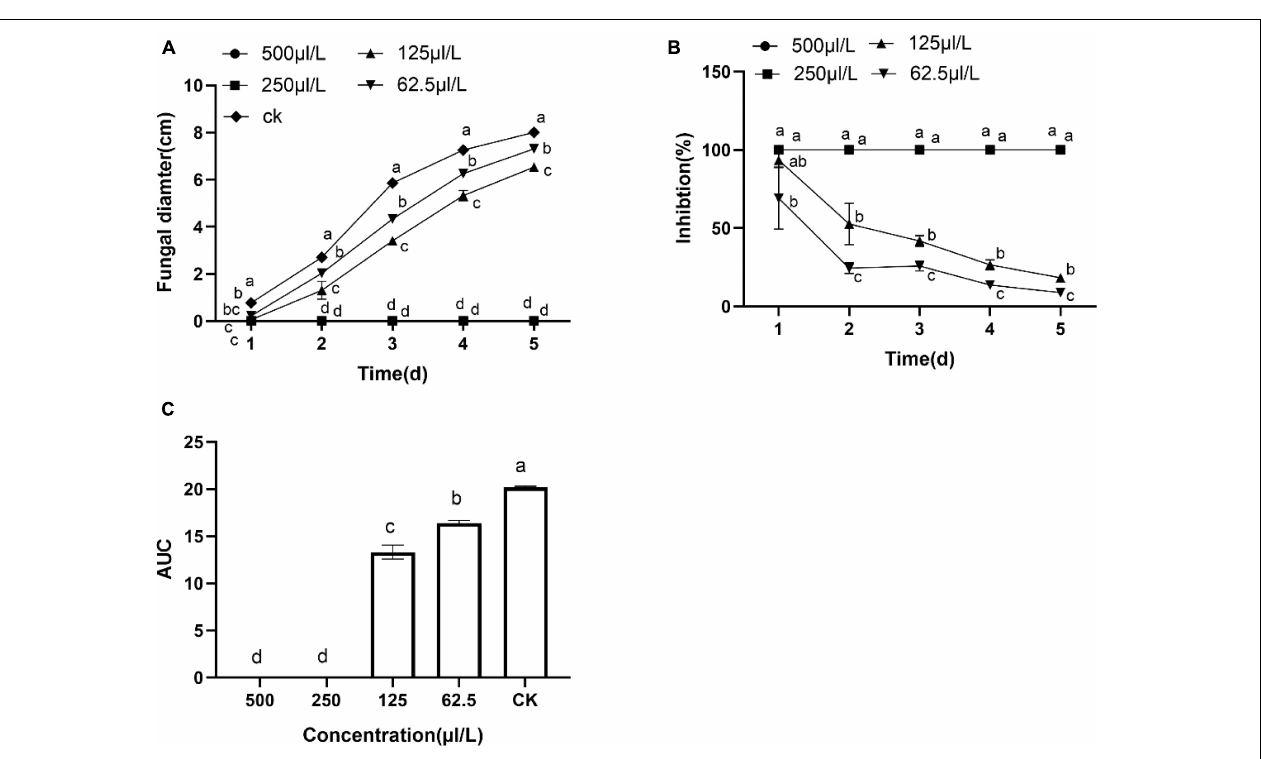
FIGURE 2 | The dimethyl trisulfide inhibition on the mycelia growth of Botryosphaeria dothidea . (A) The colony diameters of Botryosphaeria dothidea treated by the various concentration of dimethyl trisulfide. (B) The inhibition of various concentrations of dimethyl trisulfide against mycelia growth of Botryosphaeria dothidea . (C) The area-under-curve (AUC) of fungal colony diameters treated by various concentrations of dimethyl trisulfide. Different lowercase letters indicate a significant difference between treatments ( P <